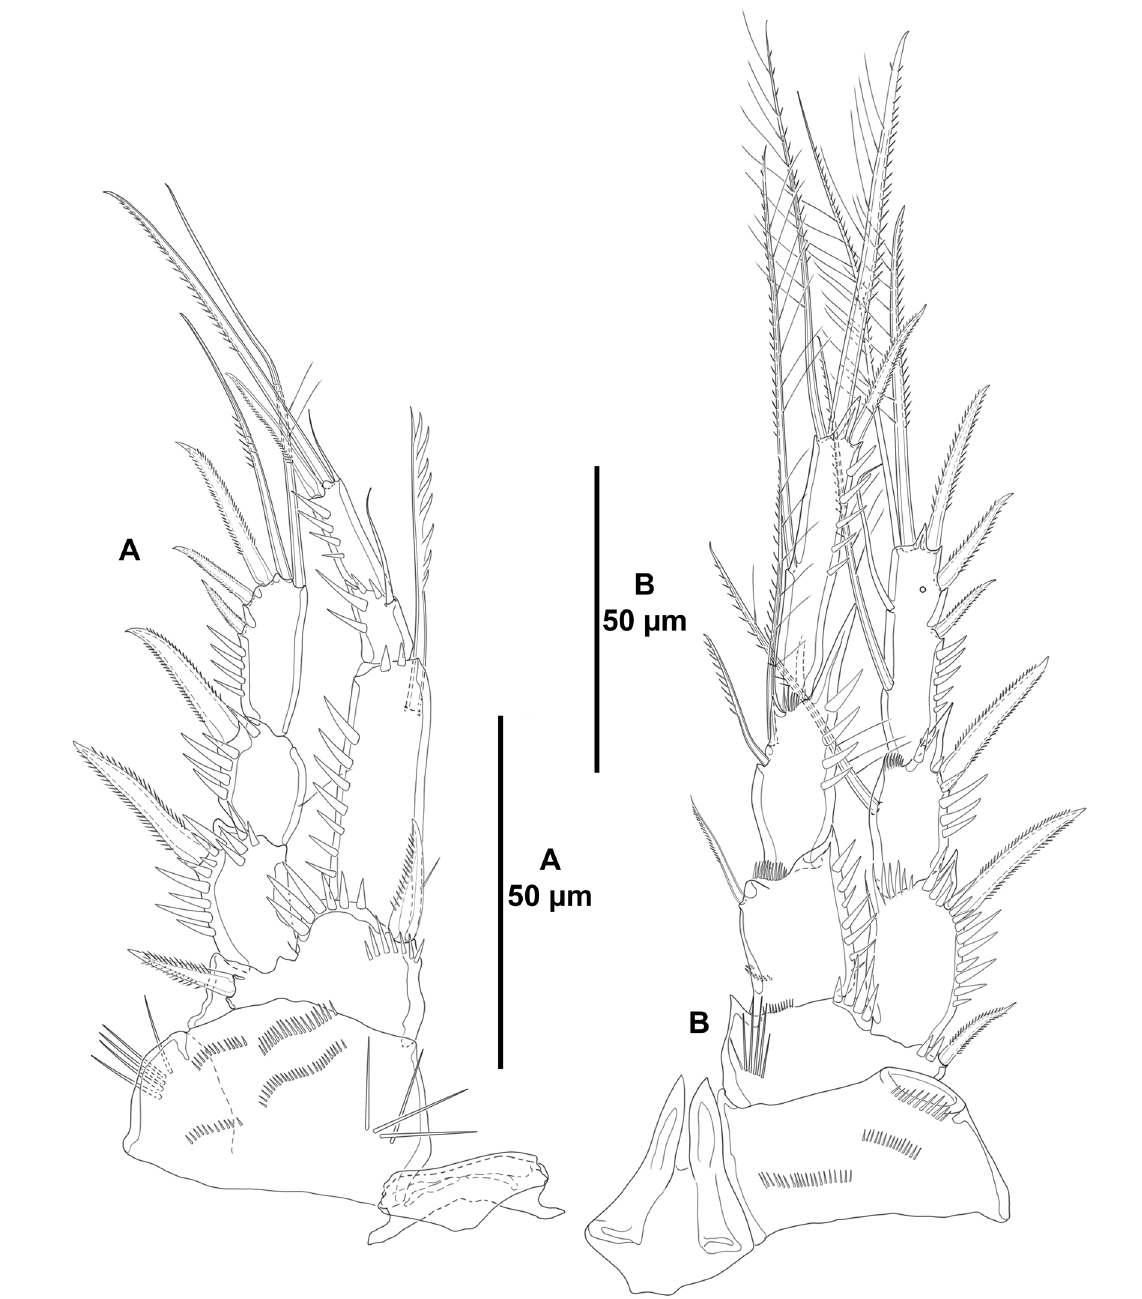
Fig. 15. Spinodiosaccus primus gen. et sp. nov., paratype, ♀ (ICML-EMUCOP-180119-65). A . P1, anterior view. B . P2, anterior